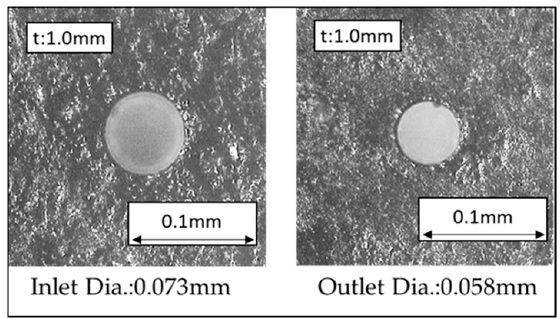
Figure 18. Micro-hole drilling of high aspect ratio on WC-Co through a desktop micro-EDM system.